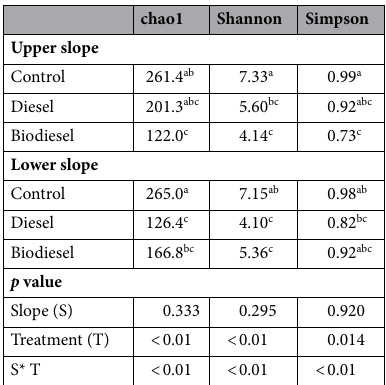
Table 1. Alpha diversity indexes of bacterial communities in an upper slope and a lower slope soil under three different treatments (control, biodiesel and diesel). Different letters indicate significant differences (Tukey HSD p < 0.05) (n = 5) after 1 year of